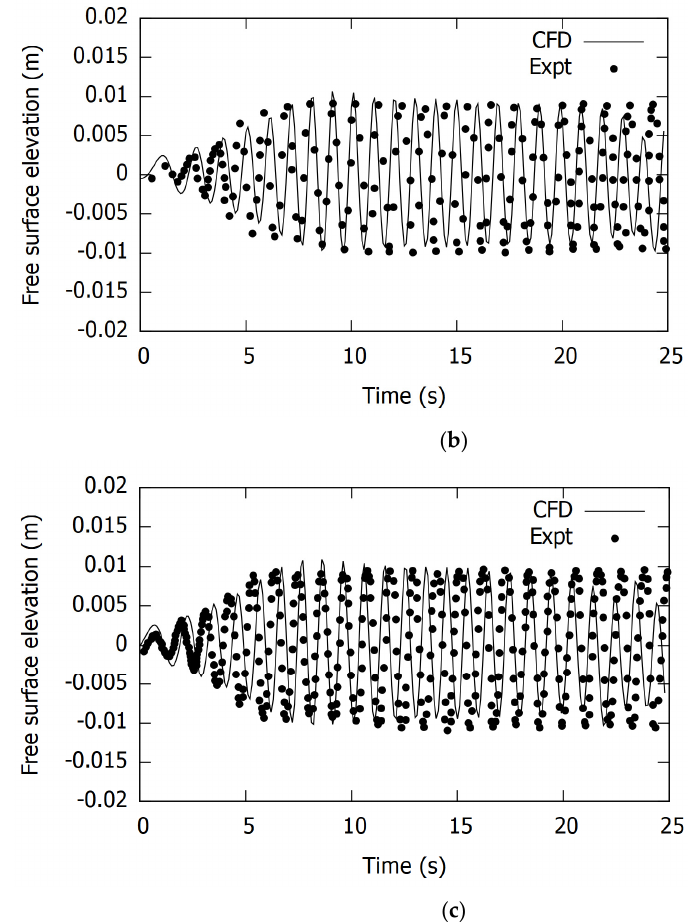
Figure 3. Water surface elevation at ( a ) WG3, ( b ) WG4, and ( c ) WG5 showing the comparison between the present CFD prediction and Rezanejad et al.’s [13] experiment for the case of the time period, 𝑇 = 1 s and wave height, 𝐻 = 0.02 m. WG3, WG4, and WG5 are located at 8.65 m, 8.95 m, and 9.35 m from the wave generator. Table 2. Mesh independency test.